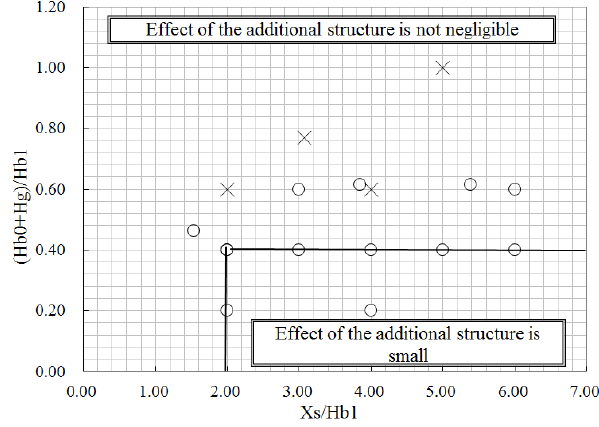
Figure 8. Effect of additional structure on effective stack height for 1.0 < Hs/Hb1 < 2.5.